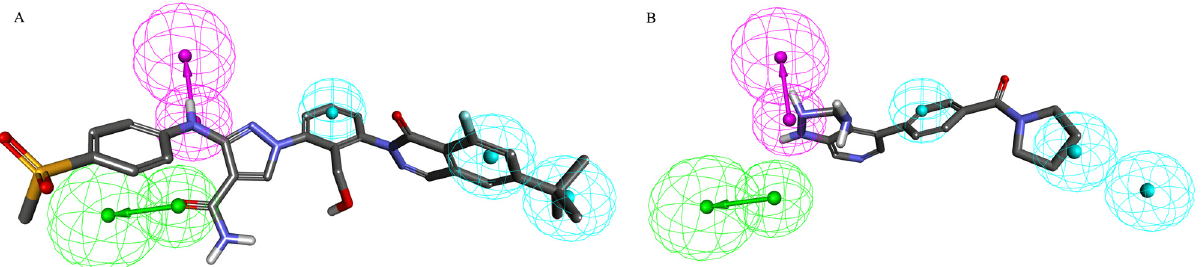
Fig 3. The best pharmacophore model Hypo1 aligned to training set compounds: A) most active compound 1 (IC50 0.09 nmol/L) and B) least activity compound 20 (IC50 40570 nmol/L). The most active compound mapped to all four features in Hypo 1, whereas the least active compound mapped only two